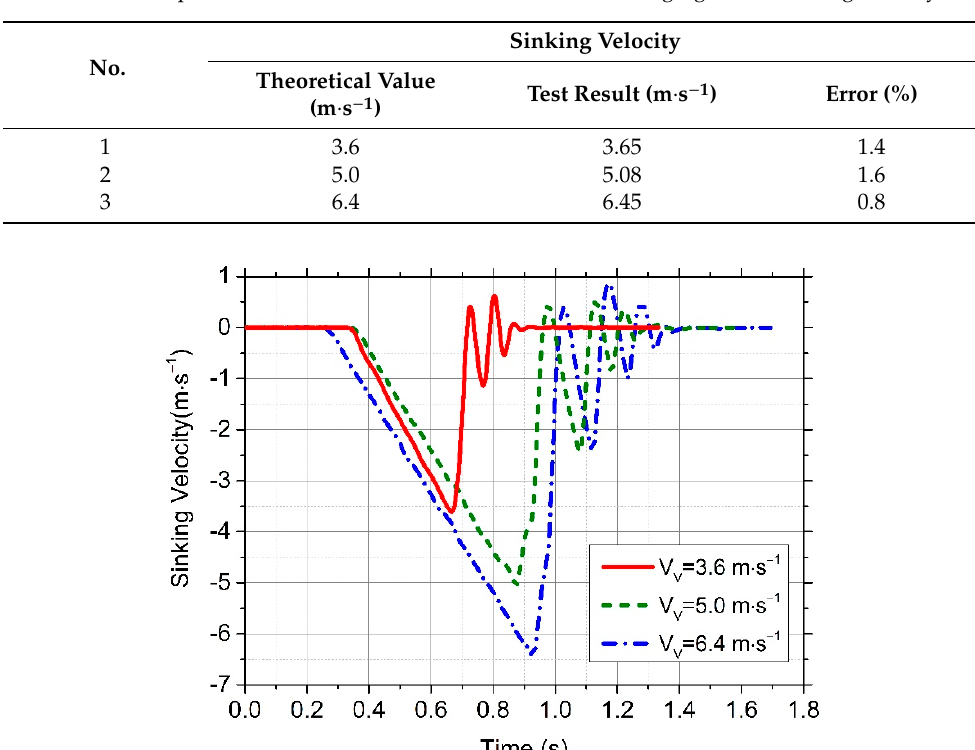
Figure 14. Curves of time history of hanging basket sinking velocity.